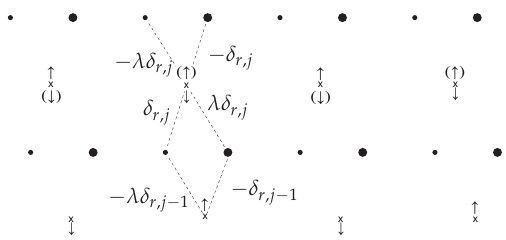
Figure 8. Electron–anion ( (TMTTF) 2 X and their alloys. The arrows depict anion displacements for the ( 1